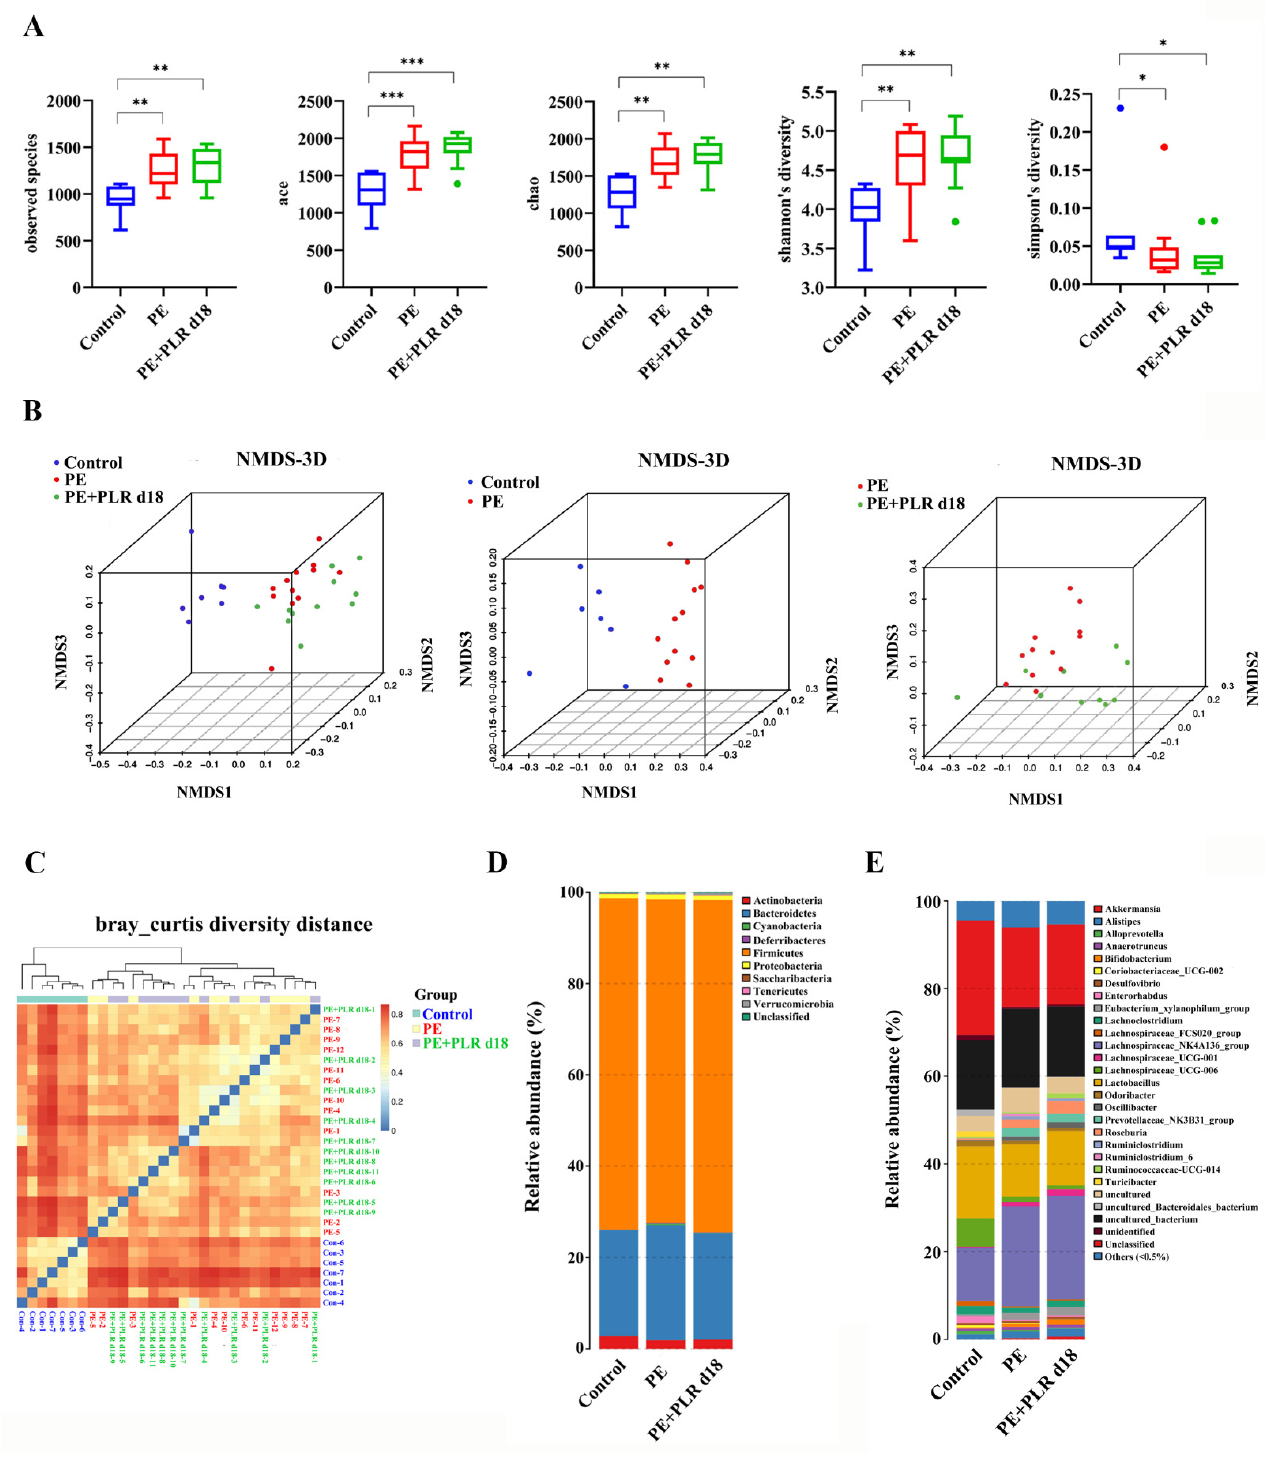
Figure 6. PLR affected the composition of gut microbiota in PE mice. ( A ) α -Diversity analysis including the observed species, Ace, Chao, Shannon, and Simpson indexes. β -Diversity analysis including the nonmetric multidimensional scaling (NMDS) ( B ) and heatmap ( C ) based on the Bray– Curtis diversity distance. ( D , E ) Relative abundance at the phylum level and genus level. In this figure, n = 7–12 for each group. Data are expressed as the mean ± SEM. * p < 0.05, ** p < 0.01, *** p < 0.001 (Kruskal–Wallis test).